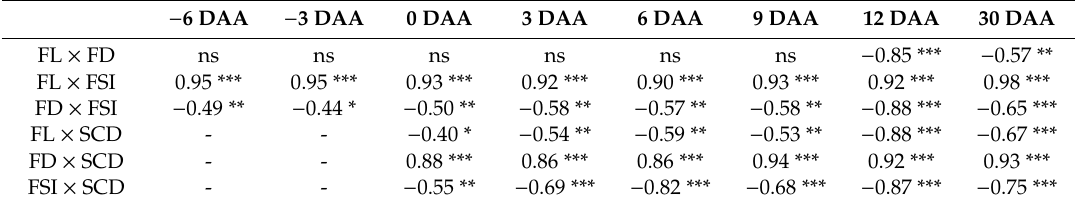
Table 1. Pearson correlation coe ffi cients for fruit size- and shape-related traits at di ff erent development stages among nine typical cucumber inbred